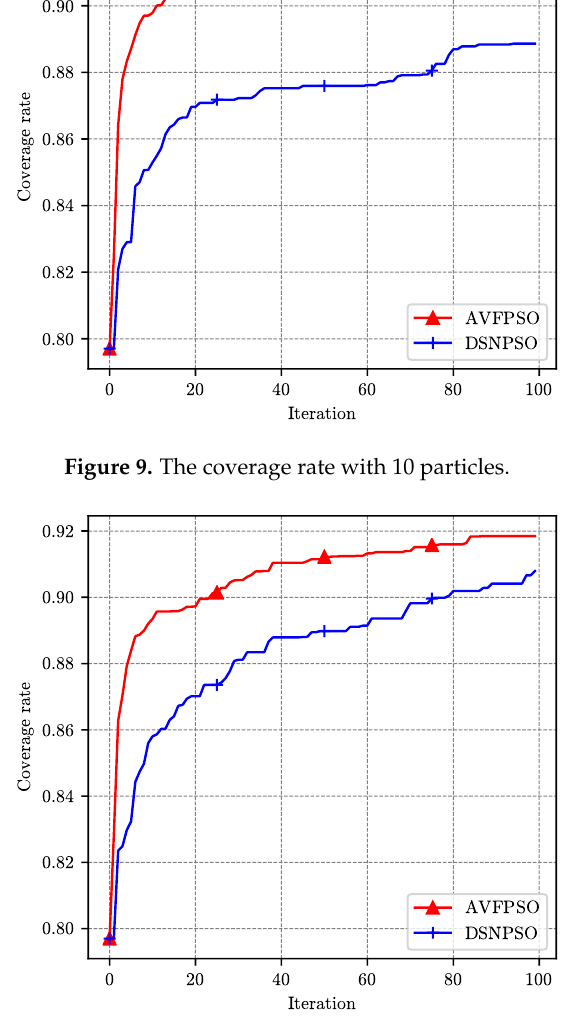
Figure 10. The coverage rate with 20